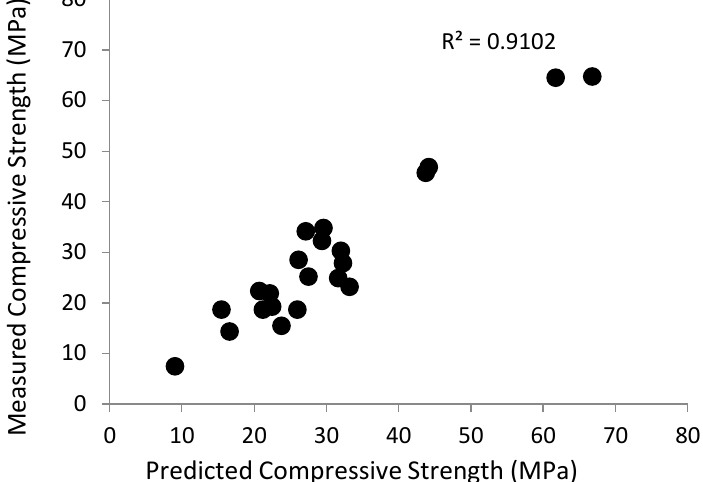
Fig. 9. Relationship between the Measured and Predicted Values of RBA concrete for Test Step of ANN